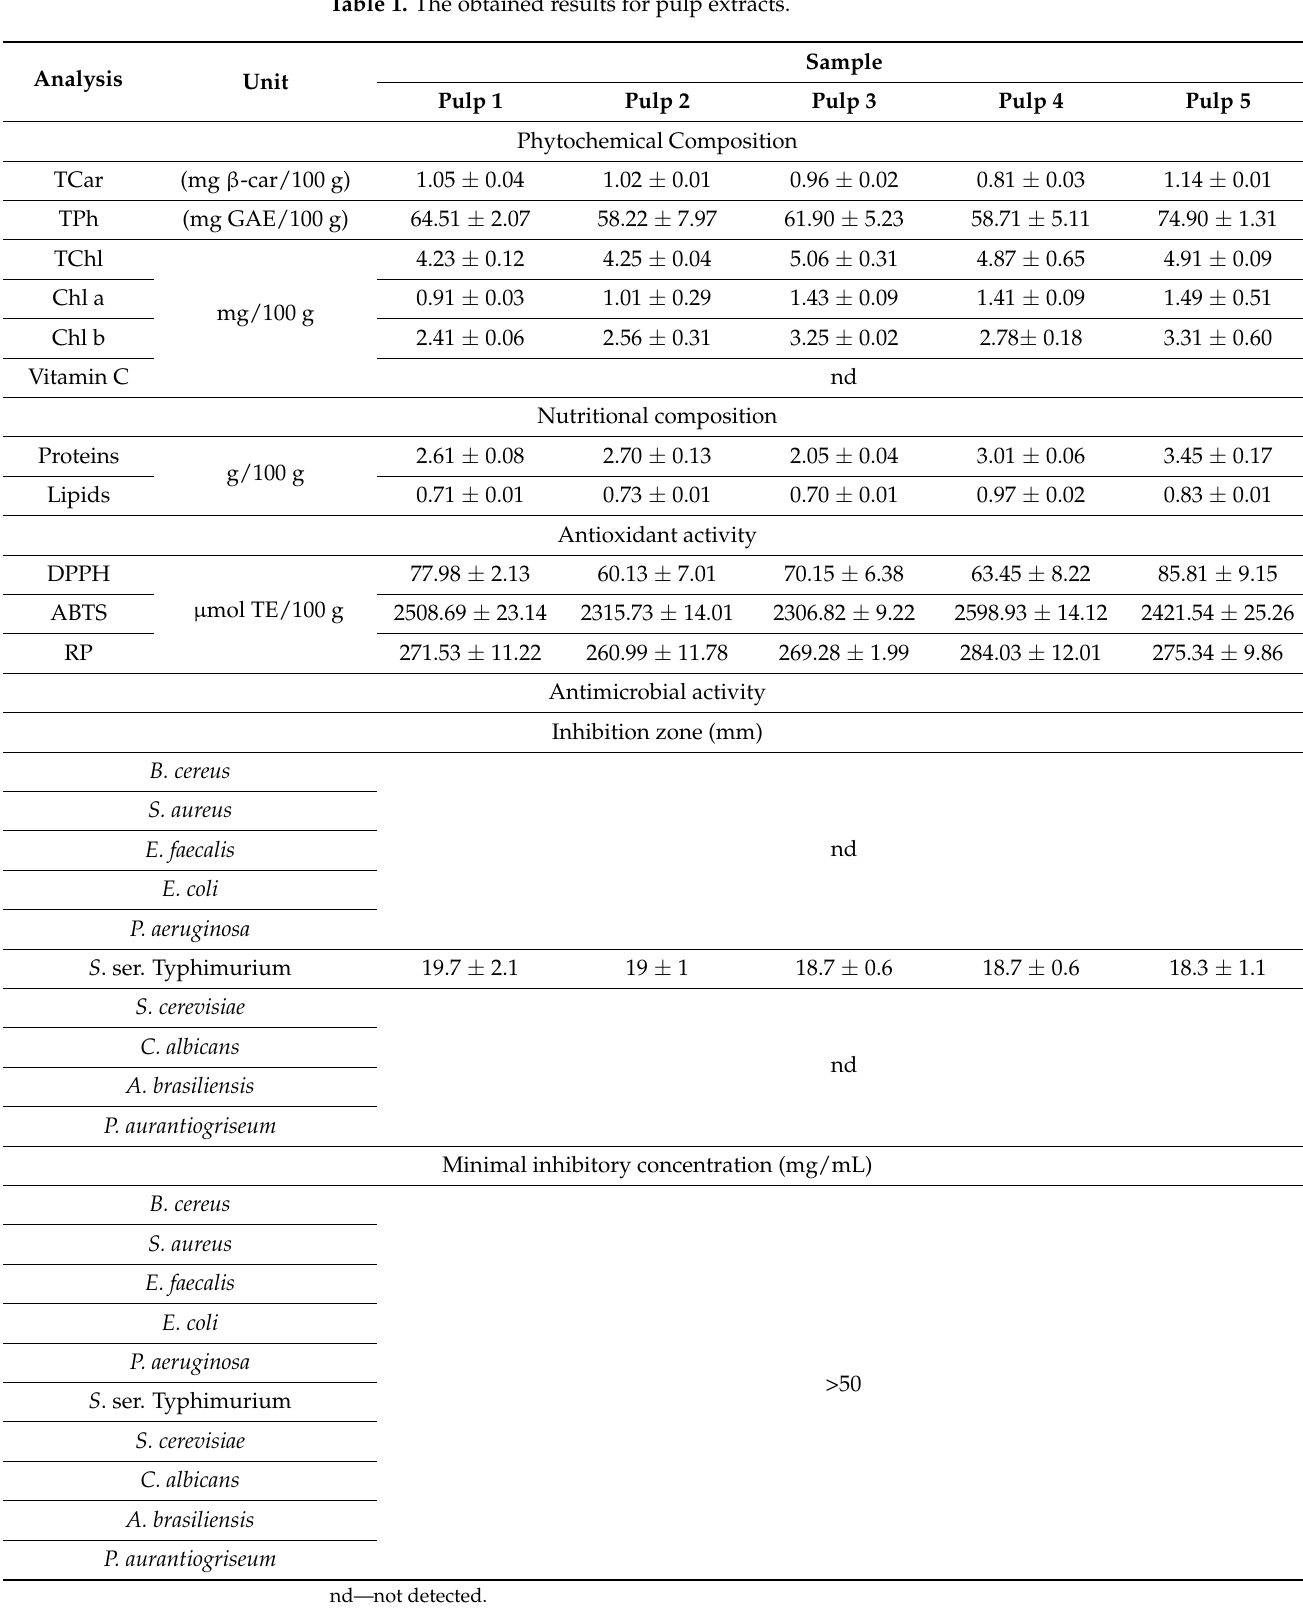
Table 1. The obtained results for pulp